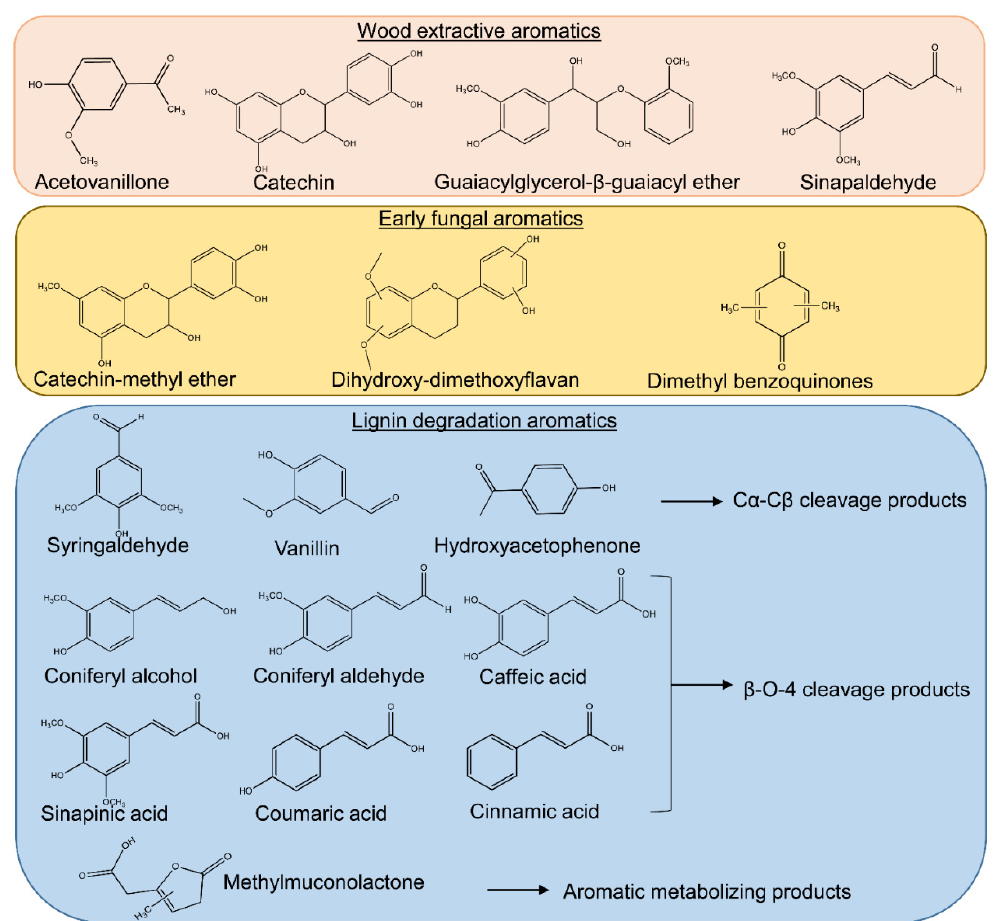
Figure 3. Key aromatic metabolites detected in both brown rot initiation and continuation in R. placenta . Tentative aromatic identities were pinpointed by MALDI-FTICR-MS for wood extractives, early stages, and advanced stages of brown rot. The putative lignin degradative pathways and their corresponding ligninolytic products were identified according to previous studies for advanced brown rot stages [1,15,16].